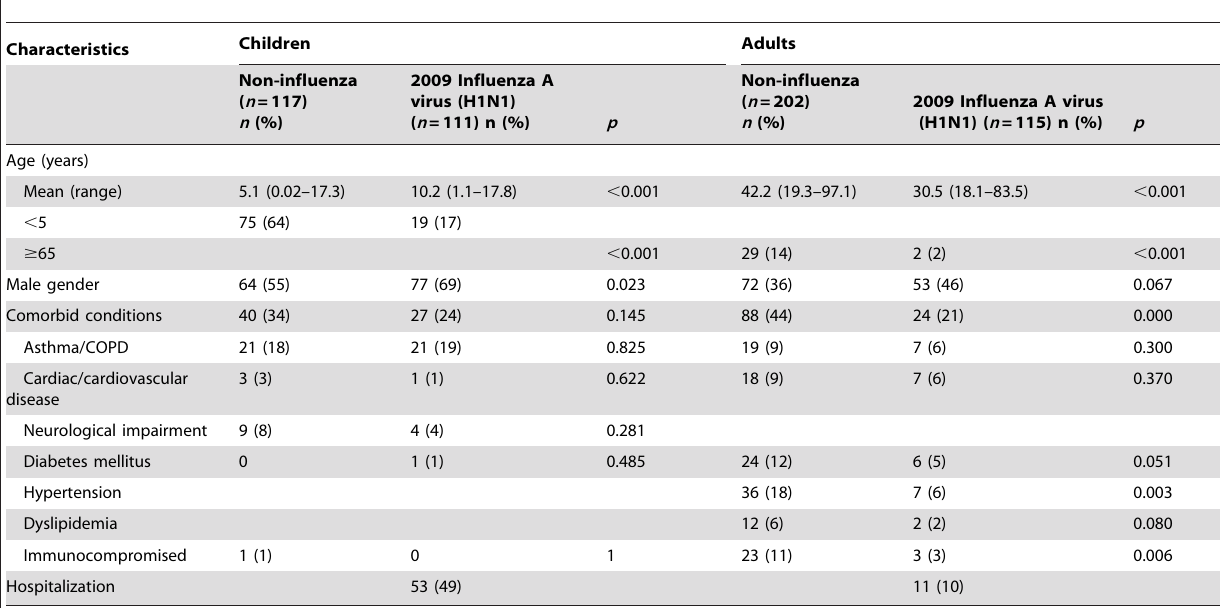
Table 1. Demographic characteristics and comorbidities in patients with non-influenza illness and 2009 influenza A virus (H1N1)